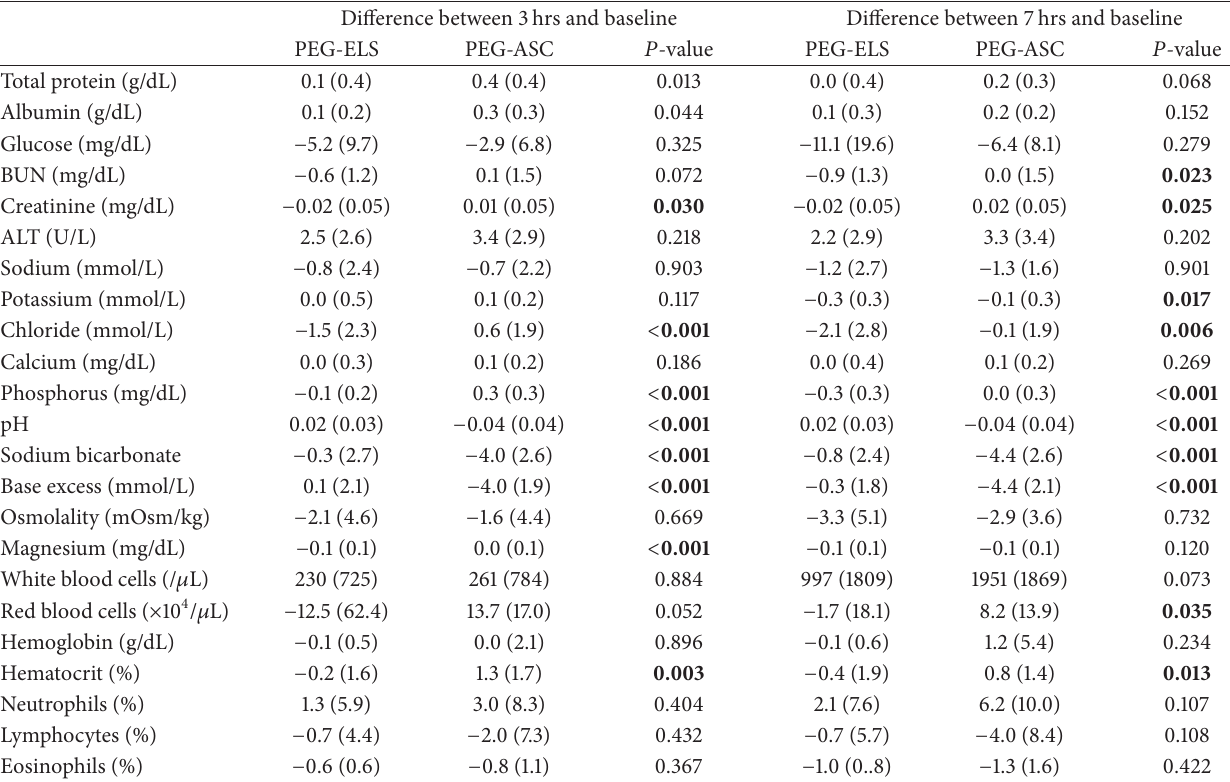
Table 5: Differences in laboratory results between baseline and 3 hours and 7 hours after taking gut lavage solution in patients aged less than 70